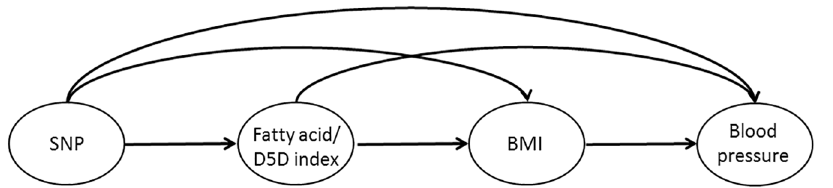
Fig 2. Theoretical models displaying the direct effects in proposed pathways through which BP (SBP or DBP, respectively) is affected by the SNP (rs174546),by fatty acids (DGLA, ARA, EPA, D5D index) as well as by BMI.